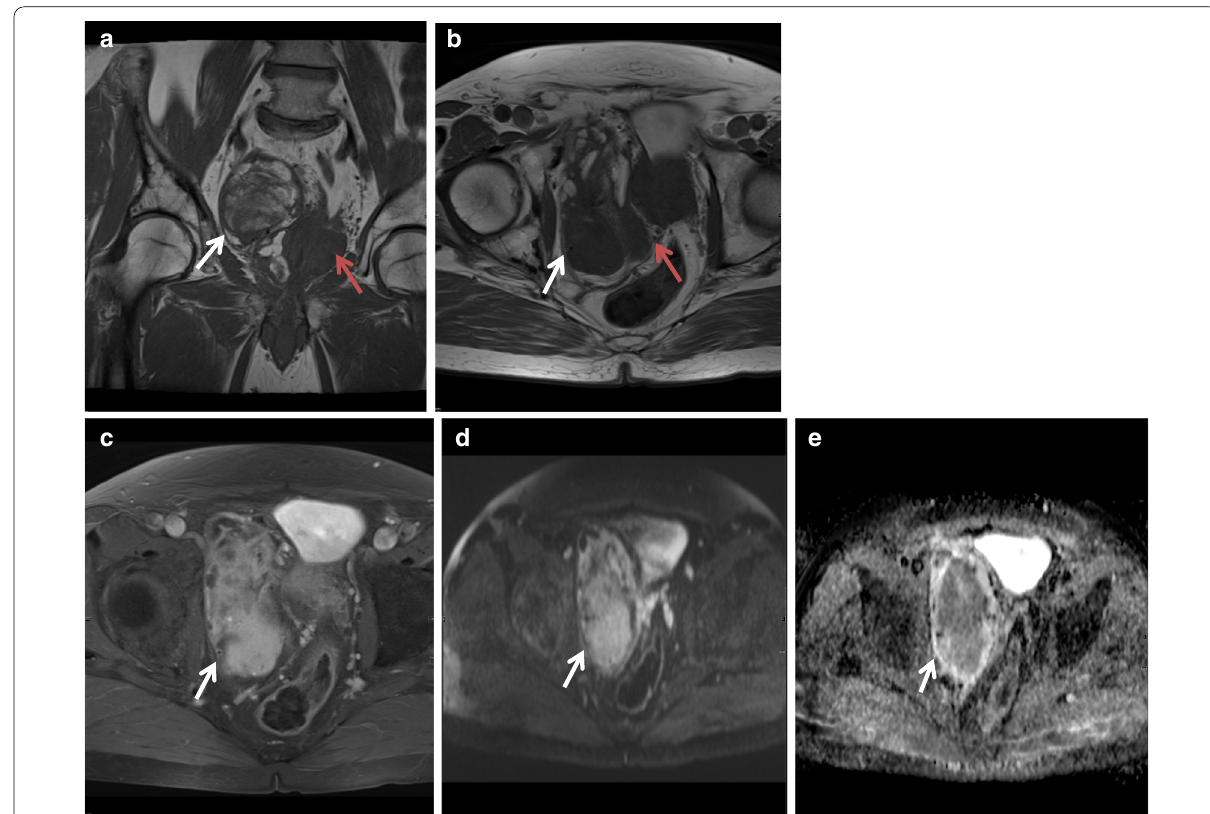
Fig. 14 Liposarcoma a Coronal and ( b ) axial T1-weighted images show a heterogeneous mass (white arrow) which is T1 iso- to hyperintense to prostate (red arrow) arising from the right of the prostate gland which does not fully supress on ( c ) T1 fat saturation with heterogeneous contrast enhancement in the non-fat elements. d , e DWI and ADC sequences, respectively, show diffusion restriction in the lesion. Surgical resection confirmed